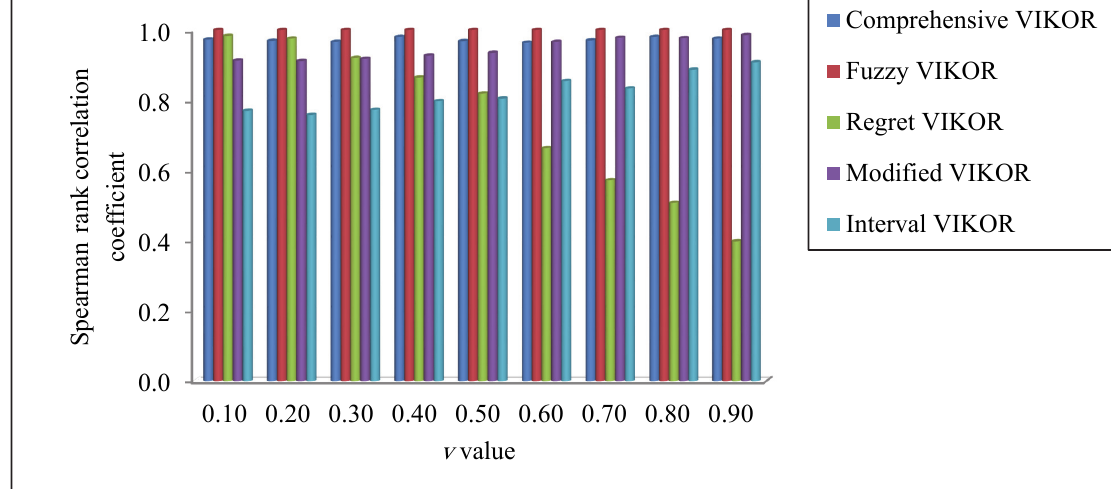
Fig. 2 Ranking performance of VIKOR method and its variants for changing v values in Example 2